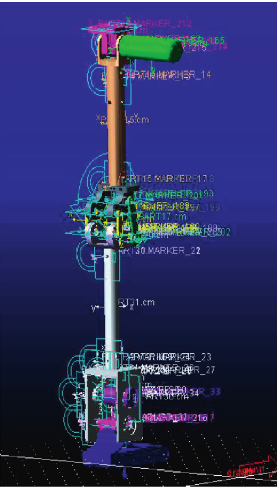
Figure 12: The virtual prototype of artificial leg in ADAMS.